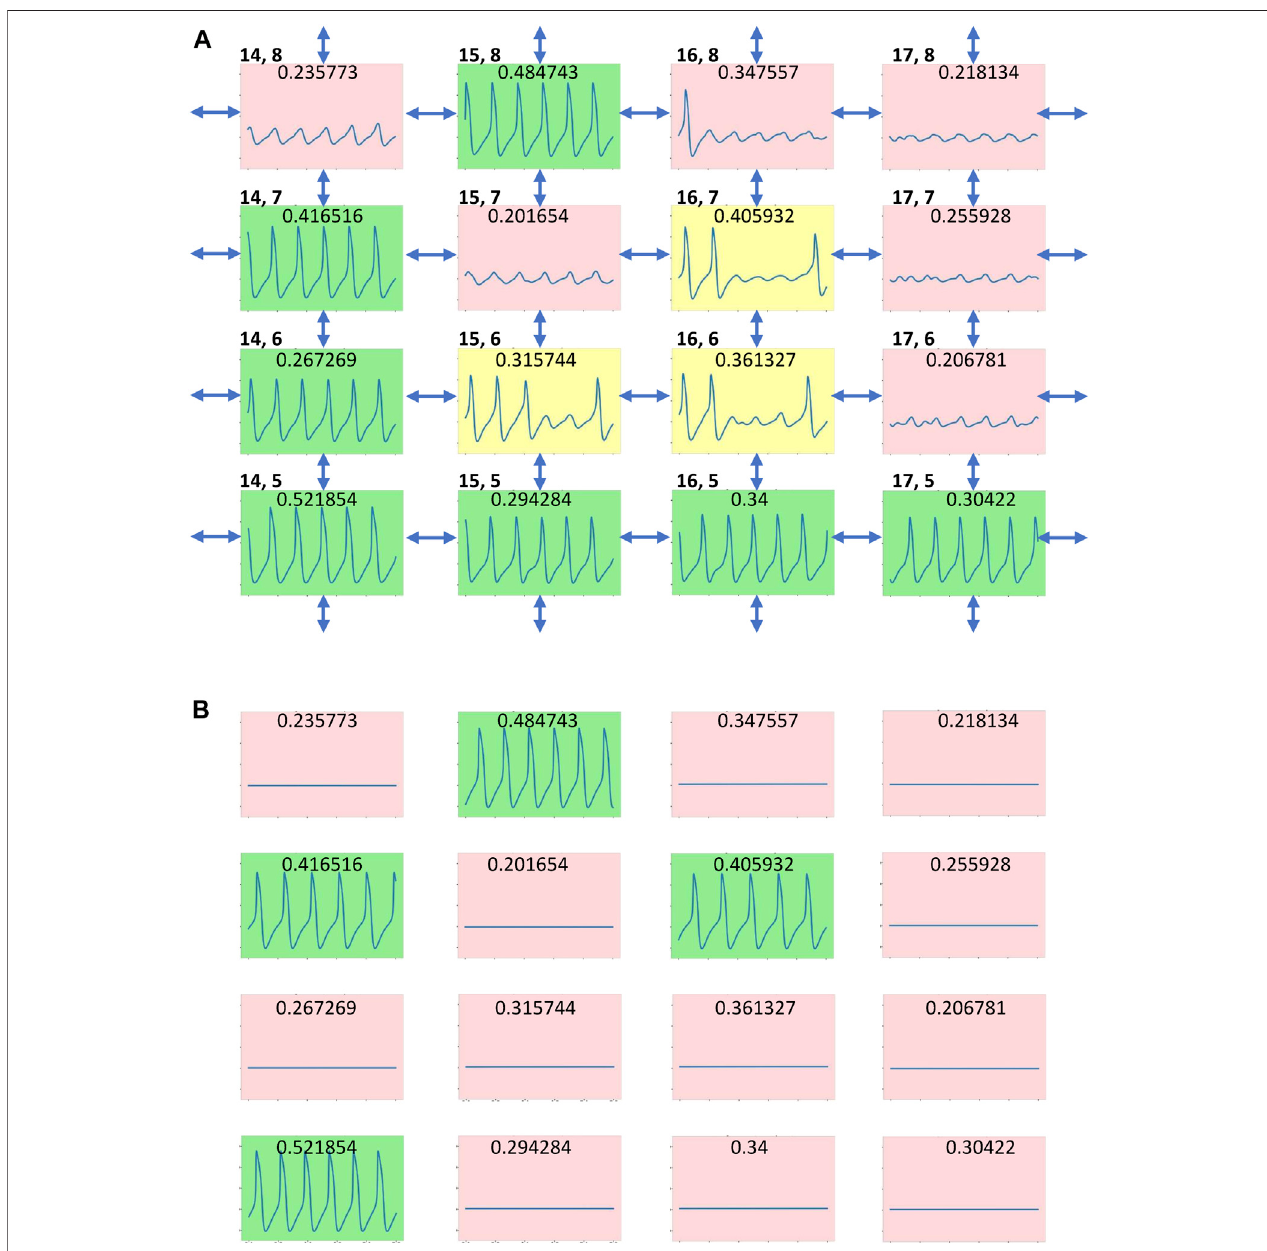
FIGURE4| Emergenceofchaotic fi ringincelltissuewithheterogenous g CaL distribution (A) AP fi ringinatissuefragmentwithalocalcommunityofthreechaotically fi ringcellsinscenario2c( Table1 , SupplementaryMoviesS2C ) (B) thesametissuefragmentwhencellsarenotconnected.Eachcellispresentedbyits2.5 s V series(from5to7.5 saftersimulationonset)inamulticolorboxdesignatingcelloperationmode:green-rhythmicAP fi ring;pink — no fi ring(subthreshold V m oscillations); and yellow — chaotic fi ring. Double headed arrows designate cell connections. g CaL value of each cell model (in nS/pF) is shown at the top of its time series. Cell coordinates (x,y) within the tissue grid are shown in the left top corner of each subpanel. The coordinates (1,1) are set for the cell in the left bottom corner in Supplementary Movies S2C . The V m scale in each subpanel is from -70 to 30 mV.